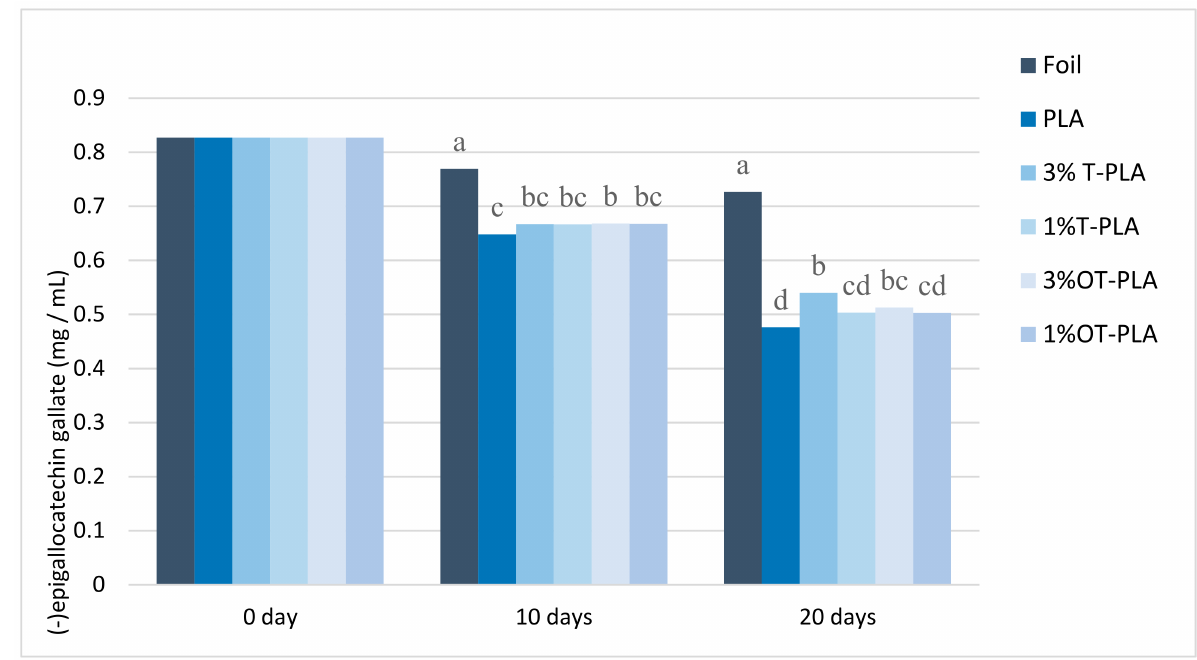
Figure 1. ( − )-Epigallocatechin gallate concentrations in green tea infusions in glass bottles covered by foil, PLA, 3% T-PLA, 1% T-PLA, 3% OT-PLA and 1% OT-PLA nanocomposite films at Days 0, 10 and 20 under fluorescent light illumination at 4 ◦ C. Significant differences between the samples are expressed with different superscript letters above the data by Tukey’s analysis with p < 0.05. Bars represent the means of three replicates, and significant differences ( p < 0.05) are presented by different